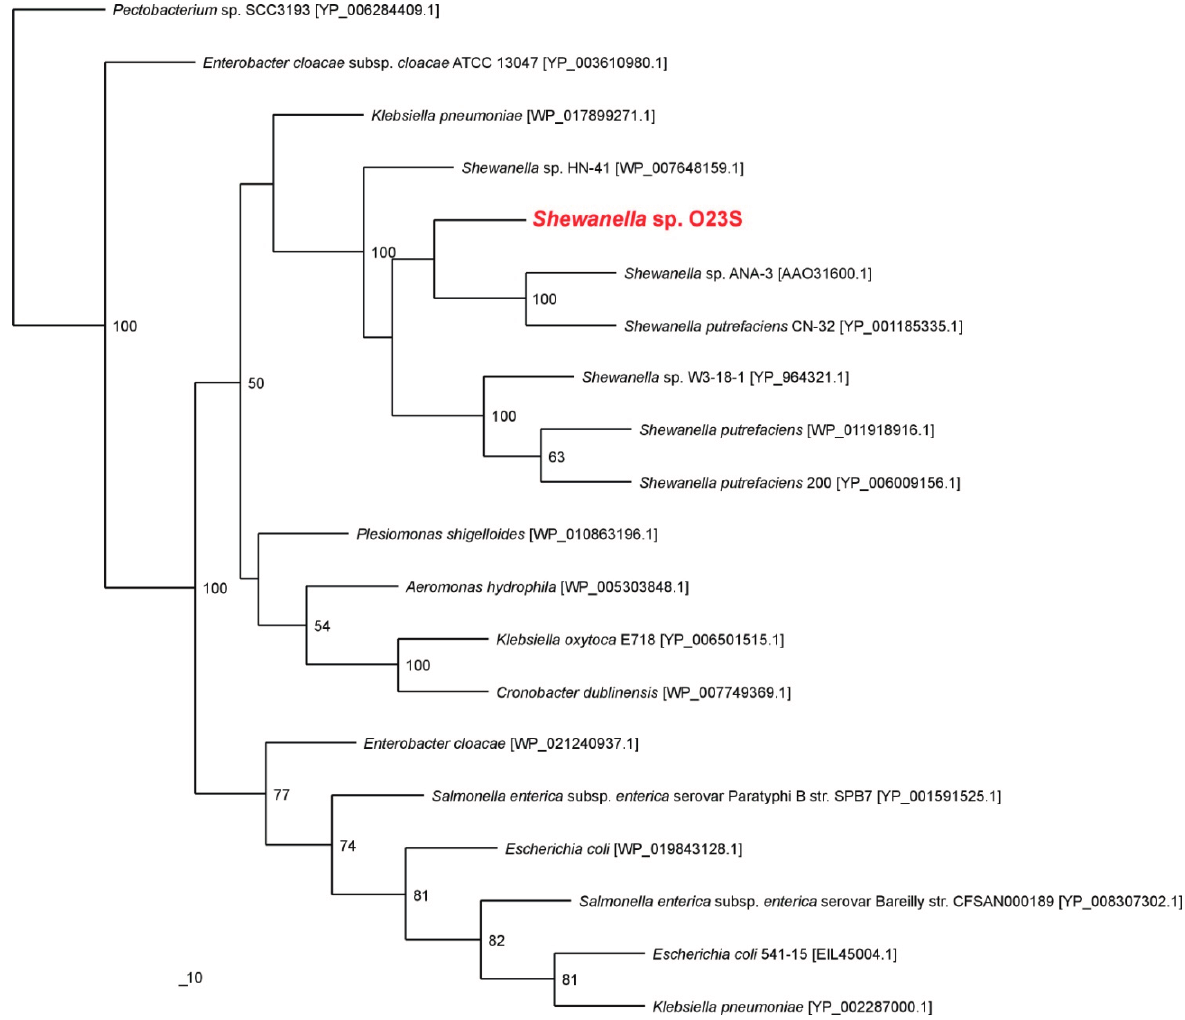
Figure 2. Phylogenetic tree of the cytoplasmic arsenate reductase ArsC based on